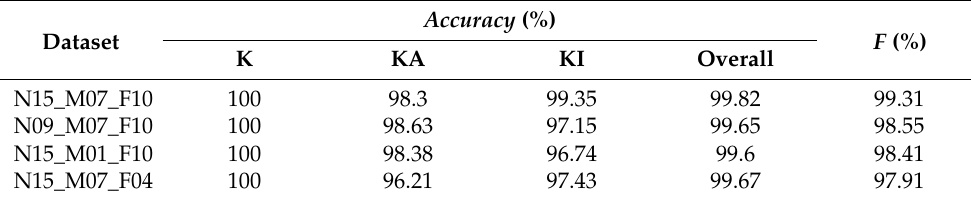
Table 6. Experimental results in different operating